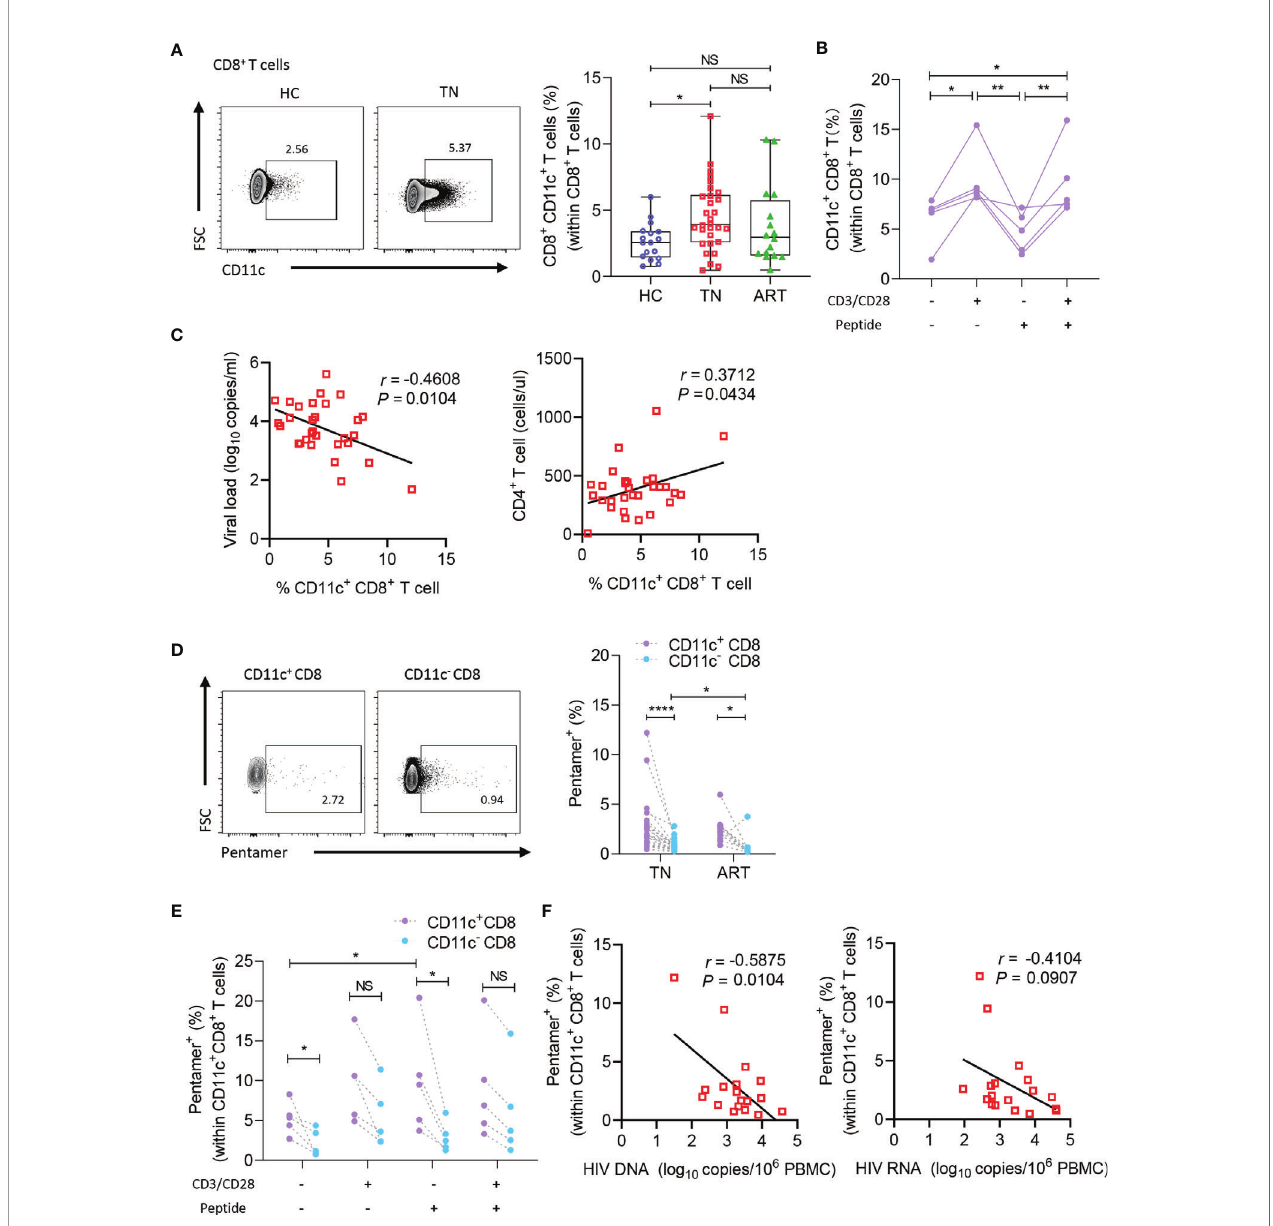
FIGURE 2 | CD11c + CD8 + T cells increase in number and negatively correlate with disease progression in HIV-1-infected patients. (A) Representative fl ow cytometry plots and the frequencies of circulating CD11c + CD8 + T cells in HCs (n = 17) and TN (n = 30) and ART (n = 34) patients. (B) Frequency of CD11c + CD8 + T cells induced by CD3/CD28 or HIV-1-derived overlapping peptides. (C) Correlation between the frequency of circulating CD11c + CD8 + T cell with plasma HIV-1 viral load and CD4 + T cell count (n = 30). (D) Representative fl ow cytometry plots and the frequencies of HIV-1-pentamer + CD11c + CD8 + T cells in PBMCs from TN (n = 22) and ART (n = 22) patients. (E) Frequency of HIV-1-pentamer + CD11c + CD8 + T cells induced by CD3/CD28 or HIV-1-derived overlapping peptides. (F) Correlation between the frequency of HIV-1-pentamer + CD11c + CD8 + T cells with HIV-1 DNA and HIV-1 usRNA (n = 18). The numbers in representative fl ow cytometry plots indicate the percentage of gated cells. * P < 0.05; ** P < 0.01; **** P < 0.0001; NS, not signi fi